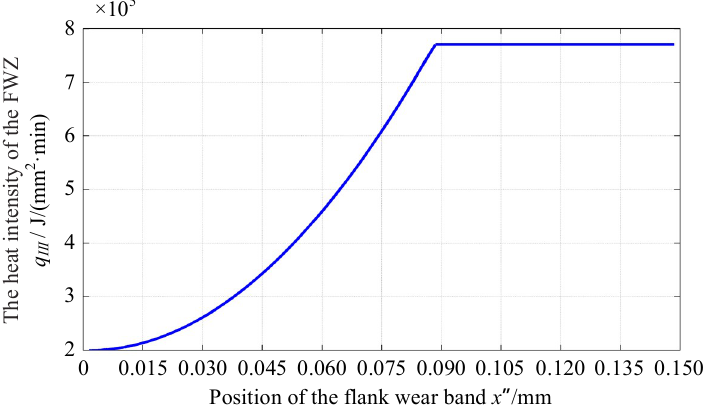
Figure 26. The heat intensity in the FWZ.